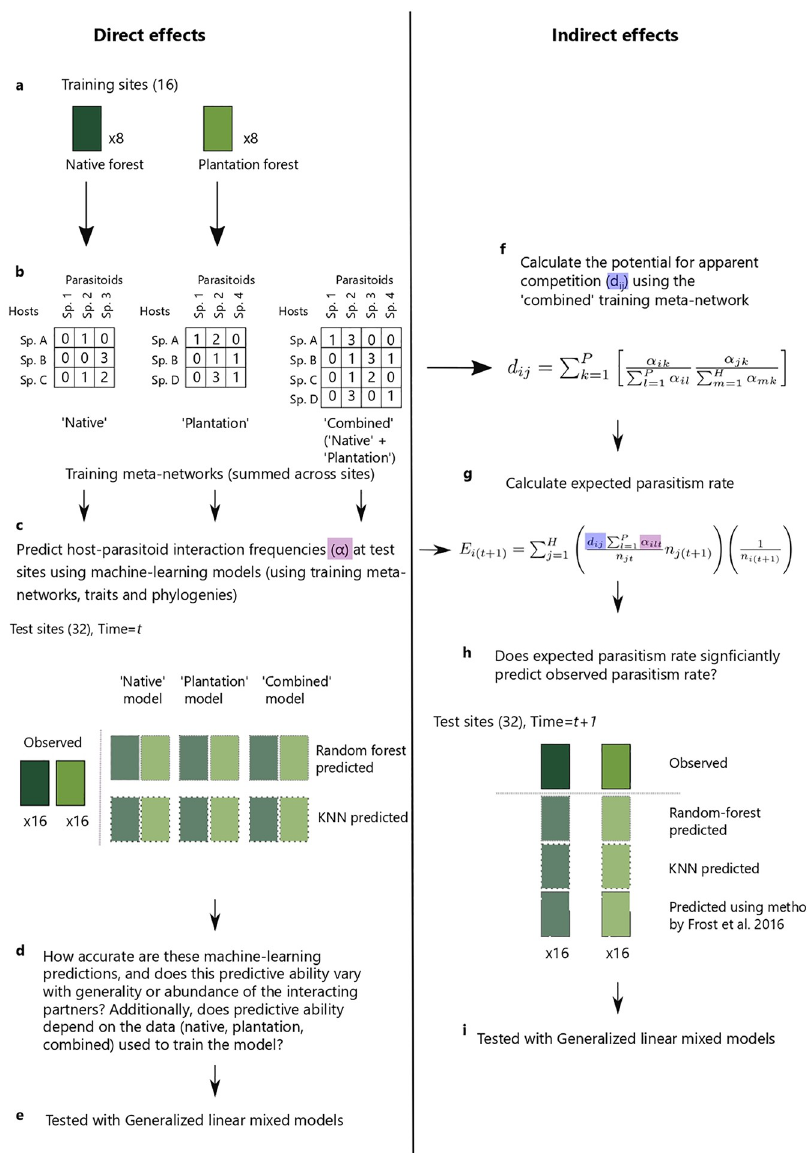
Fig 1. Summary of methods. (a) Lepidopteran larvae (‘hosts’) were collected from eight native forest sites and eight plantation forest sites (we call these ‘training sites’ as data from these sites were used to train the models). (b) Hosts were identified and reared to determine parasitism rates and identities. We created three quantitative training meta- networks (‘native’, ‘plantation’, ‘combined’) by pooling interaction data across native sites, plantation sites, and all sites, respectively. (c) We used machine-learning models (random forest and KNN), informed by training meta- networks, traits and phylogenies, to predict interaction frequencies at test sites (16 native forest and 16 plantation forest) at time t . We created a separate model for each of the three training meta-networks, for both machine-learning approaches (i.e., 6 models: random forest/KNN ‘native’/’plantation’/’combined’). (d, e) We then tested whether the ability of these machine-learning models to predict interaction frequencies depended on species generality or abundance, and whether predictive ability depended on the data (i.e. native, plantation, combined) used to inform the model. (f) We then calculated the potential for apparent competition, d ij , between each pair of host species in the training data (using both native and plantation sites data). (g) We calculated expected parasitism rates (E) for host species at time = t+1 test sites using these d ij values, along with predicted attack rates ( α ) calculated from our machine- learning predicted networks at time = t test sites, and abundance ( n ) from the test sites. We calculated expected parasitism rates (E) for both random forest and KNN. Additionally, we calculated expected parasitism rates using a data-based approach used by Frost et al . [21]. We tested whether expected parasitism rates could significantly predict observed parasitism rates at time = t+1 test sites (h,